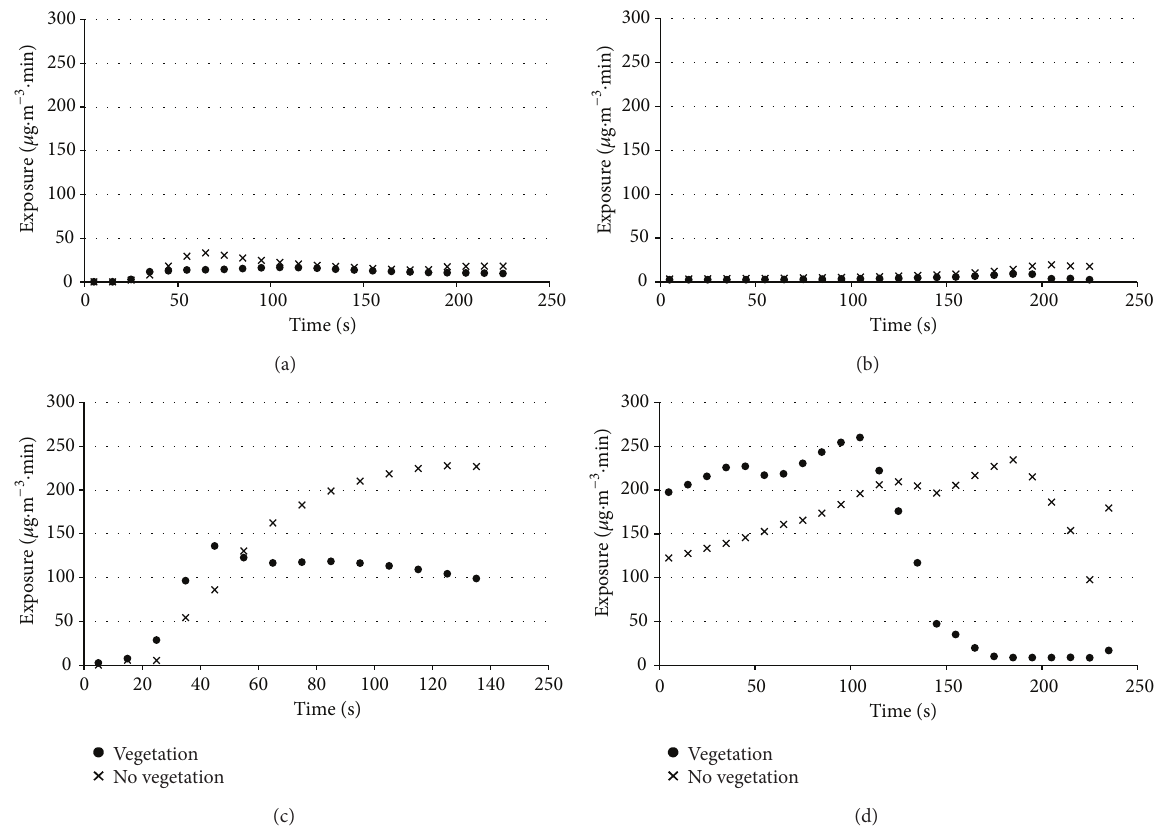
Figure 5: Time evolution of the individual exposure ( 𝜇 g ⋅ m −3 ⋅ min) to CO for each of the four considered pathways, with and without the presence of trees.